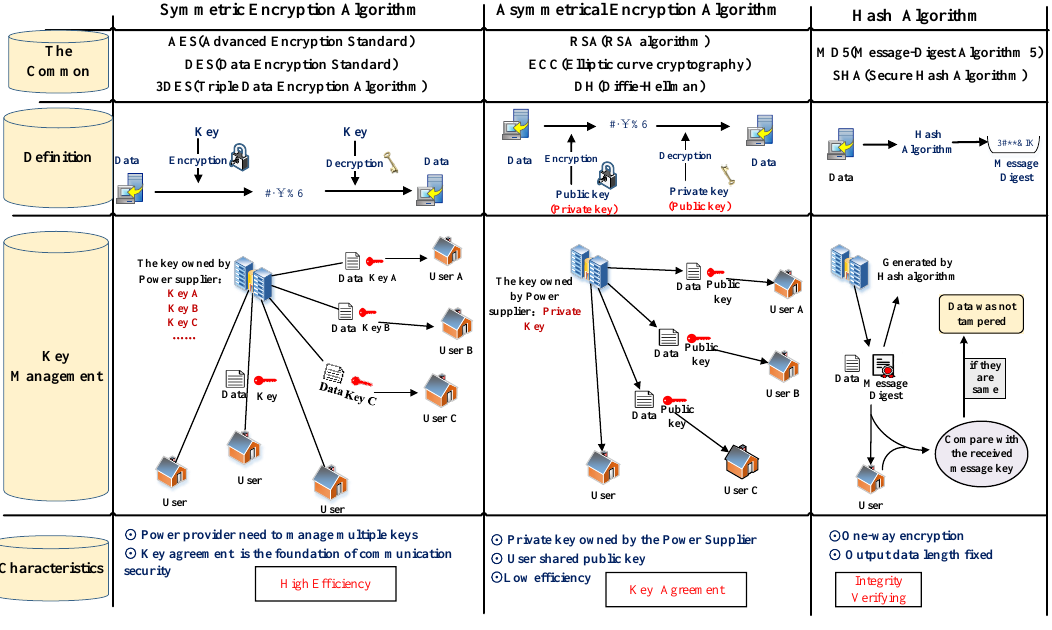
Figure 4. Classification of cryptographic algorithms.